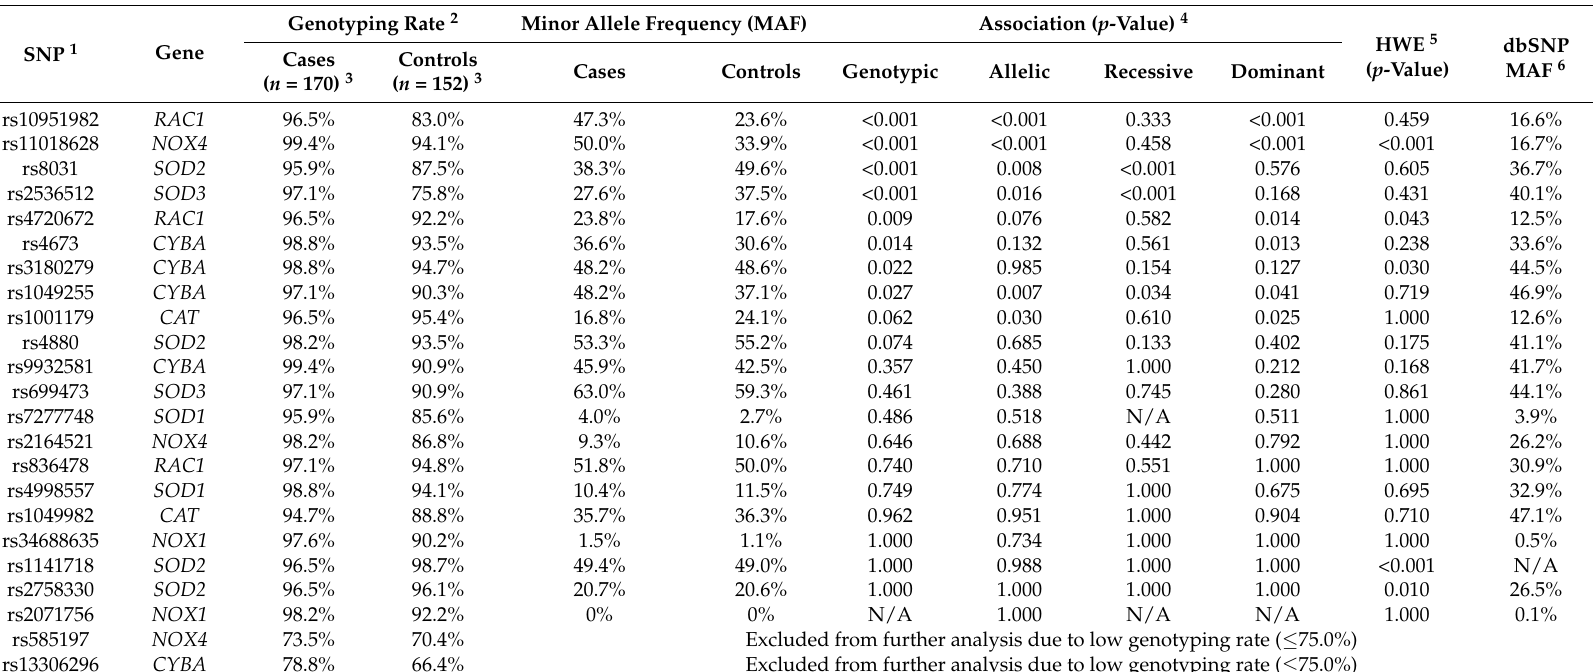
Table 3. Descriptive statistics of the 23 SNP